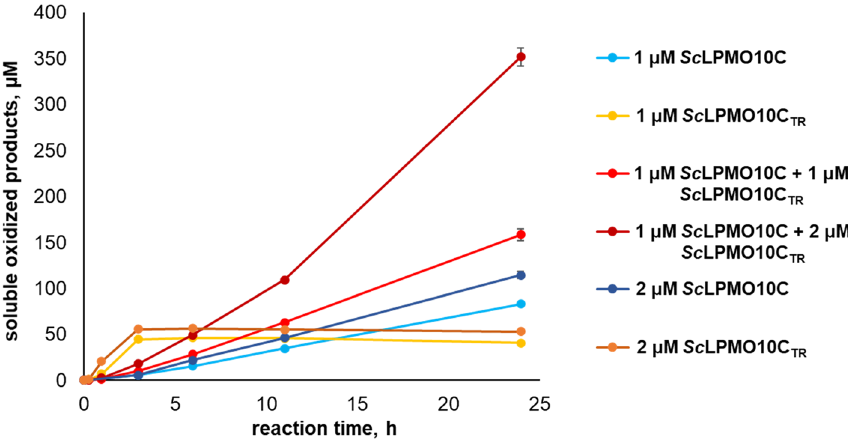
Figure 3. Cellulose oxidation by Sc LPMO10C and Sc LPMO10C TR . The graph shows soluble oxidized products released from 1% (w/v) Avicel by Sc LPMO10C, Sc LPMO10C TR or mixtures of these LPMOs in the presence of 1 mM ascorbic acid. The reactions were carried out in 50 mM sodium phosphate buffer, pH 6.0, supplied with 1 mM ascorbic acid, at 30 °C. Error bars indicate standard deviations between